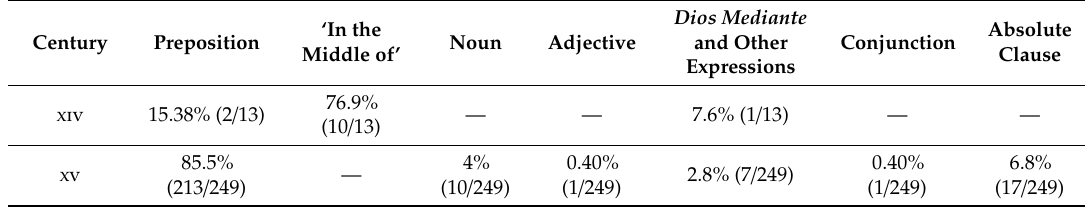
Table 1. Distribution of the uses of mediante in the xiv - xv